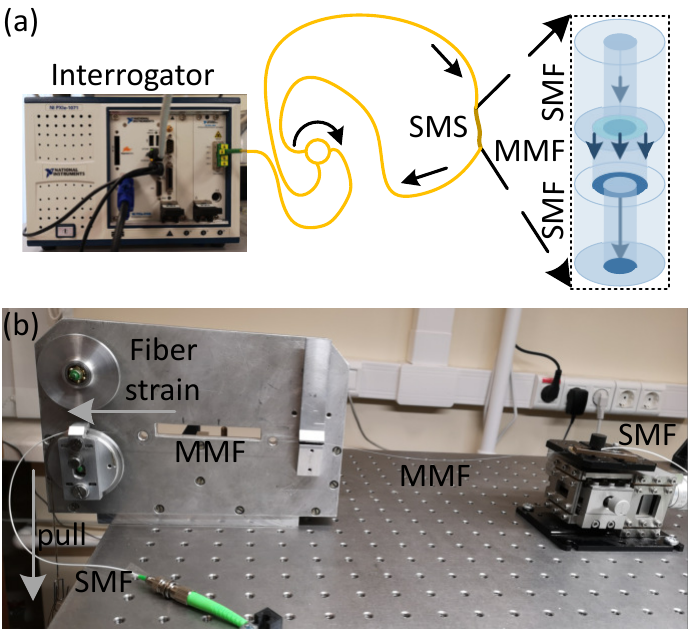
Figure 4. Schematic view of experimental setup ( a ) and a photograph of the experimental arrange- ment, used to produce a controlled simultaneous strain and bend of the sensing fiber section ( b